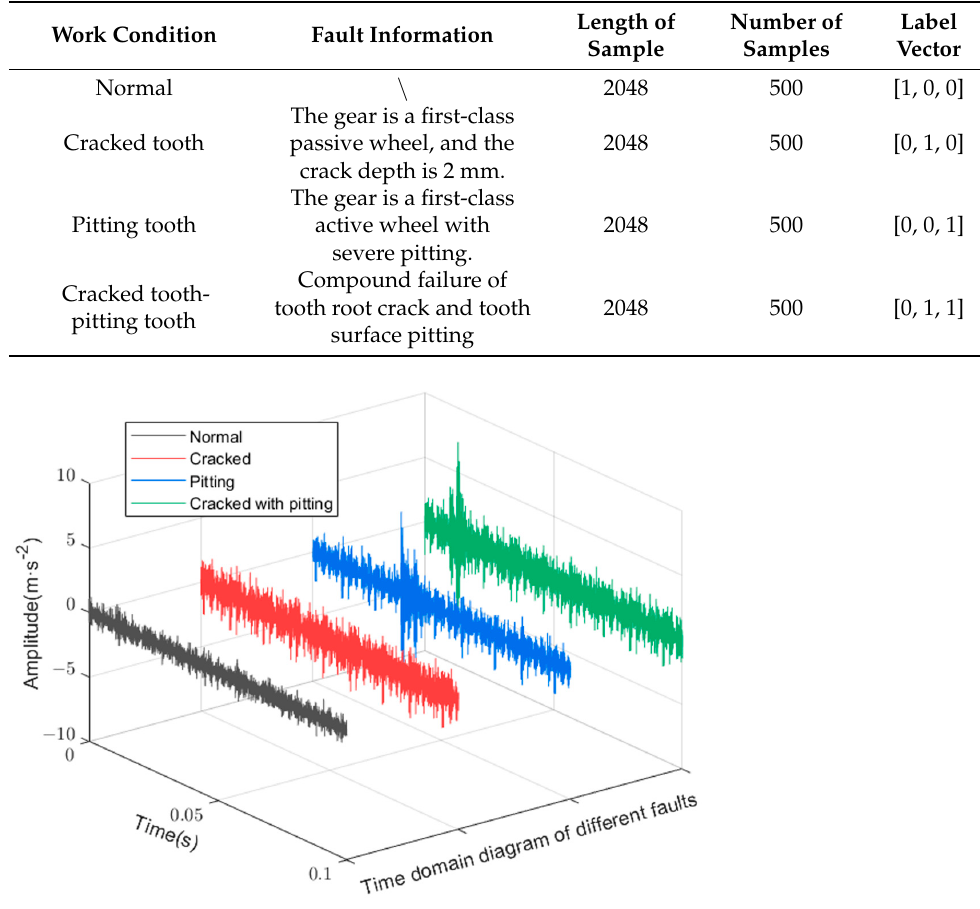
Figure 12. Time domain diagram of the simulated signal.